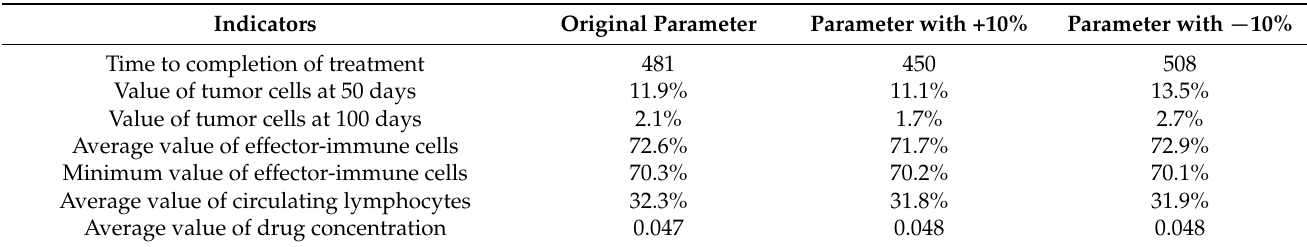
Figure 10. The changes of ( a ) tumor cells, ( b ) effector-immune cells, ( c ) circulating lymphocytes, ( d ) drug concentration, ( e ) drug dose according to different parameters on cells in patients. Table 6. Comparison of experimental indicators using different